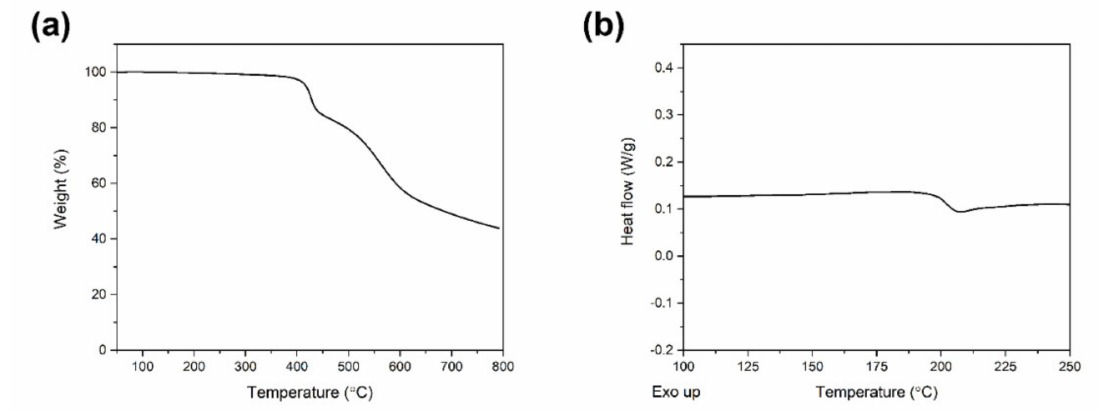
Figure 4. ( a ) TGA and ( b ) DSC thermograms of the